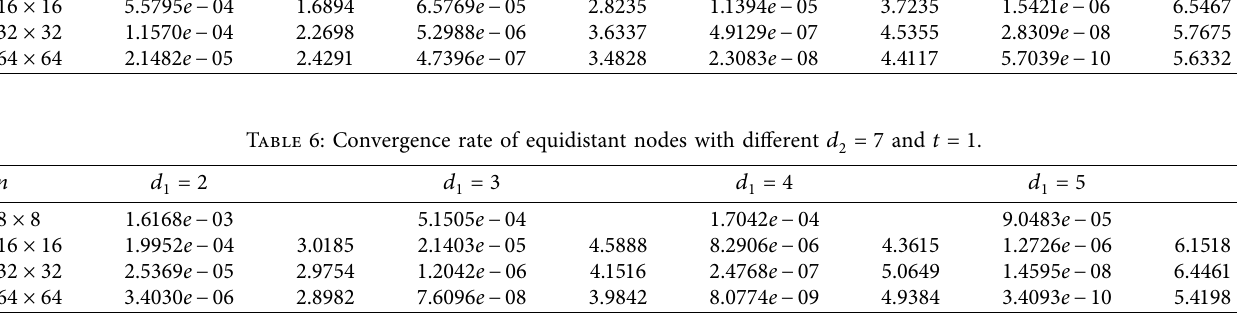
Table 7: Convergence rate of quasi-equidistant nodes with different d